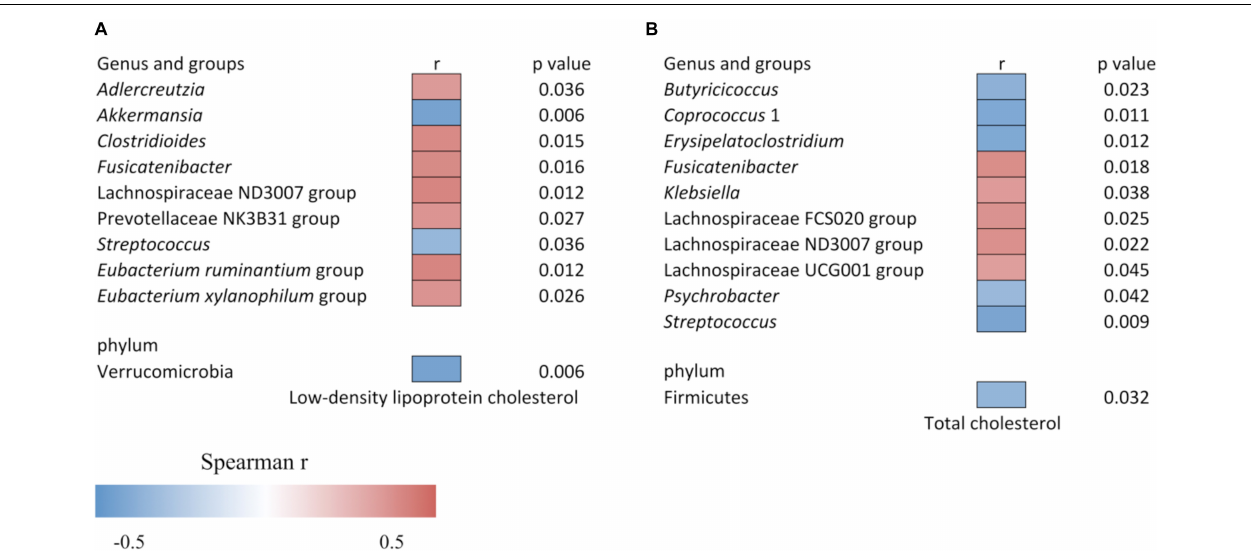
FIGURE 4 | Heat map of the Spearman correlation (A) between relative abundance of gut bacteria and low-density lipoprotein cholesterol level, and (B) between relative abundance of gut bacteria and total cholesterol level. The heat map color represents the Spearman correlation coefficient ( r ). Data is filtered for p < 0.05.